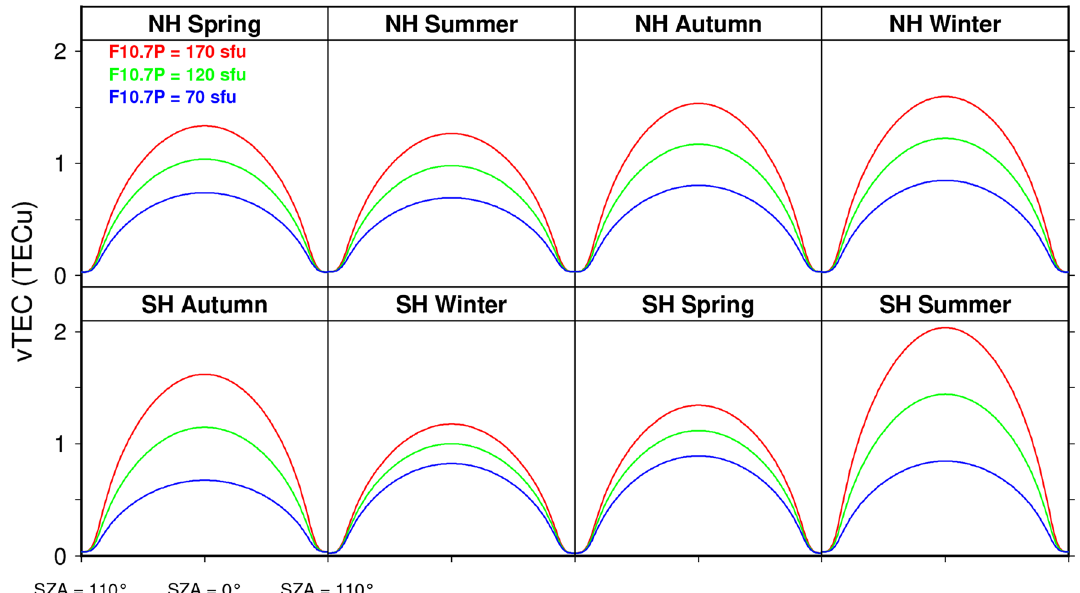
Fig. 7. Seasonal climatological behaviour of the vTEC on Mars for Northern (top, 20 (cid:3) N) and Southern (bottom, 20 (cid:3) S) hemispheres. For each season and hemisphere, each curve corresponds to the daily variation of the vTEC (i.e., SZA from 110 (cid:3) to 0 (cid:3) ). The colours correspond to different solar cycle activity levels (F10.7P = 70, 120 and 170